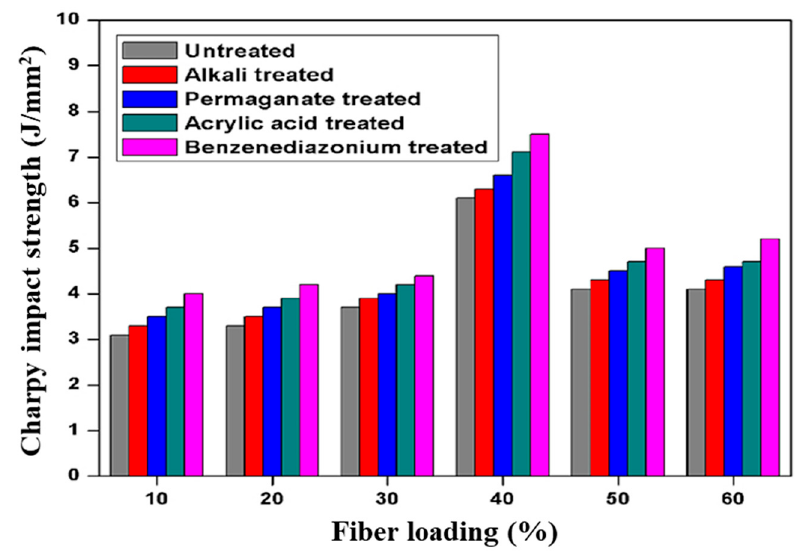
Figure 2. Effect of the fiber loading (10–60 wt.%) and chemical treatment on impact strengths of abaca-reinforced epoxy composite [110]. Reprinted with permission. Copyright 2014 MNFR.